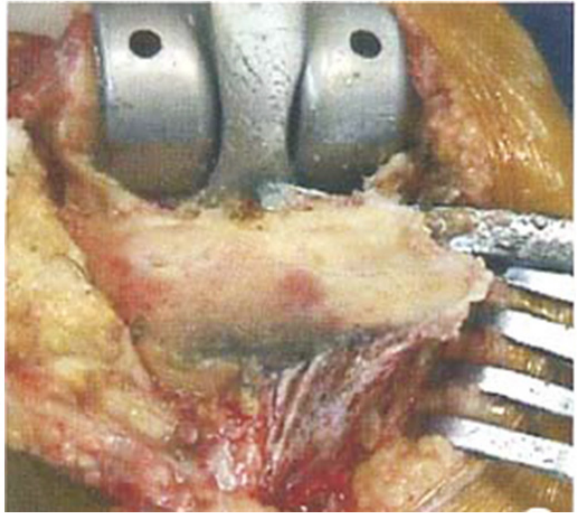
Figure 1: The eave-shaped change of medial tibial plateau after osteotomy.